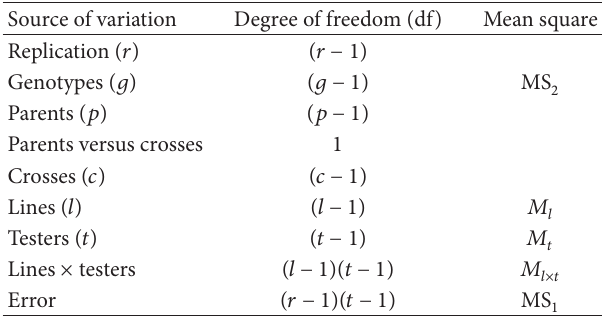
Table 1: ANOVA for line × tester